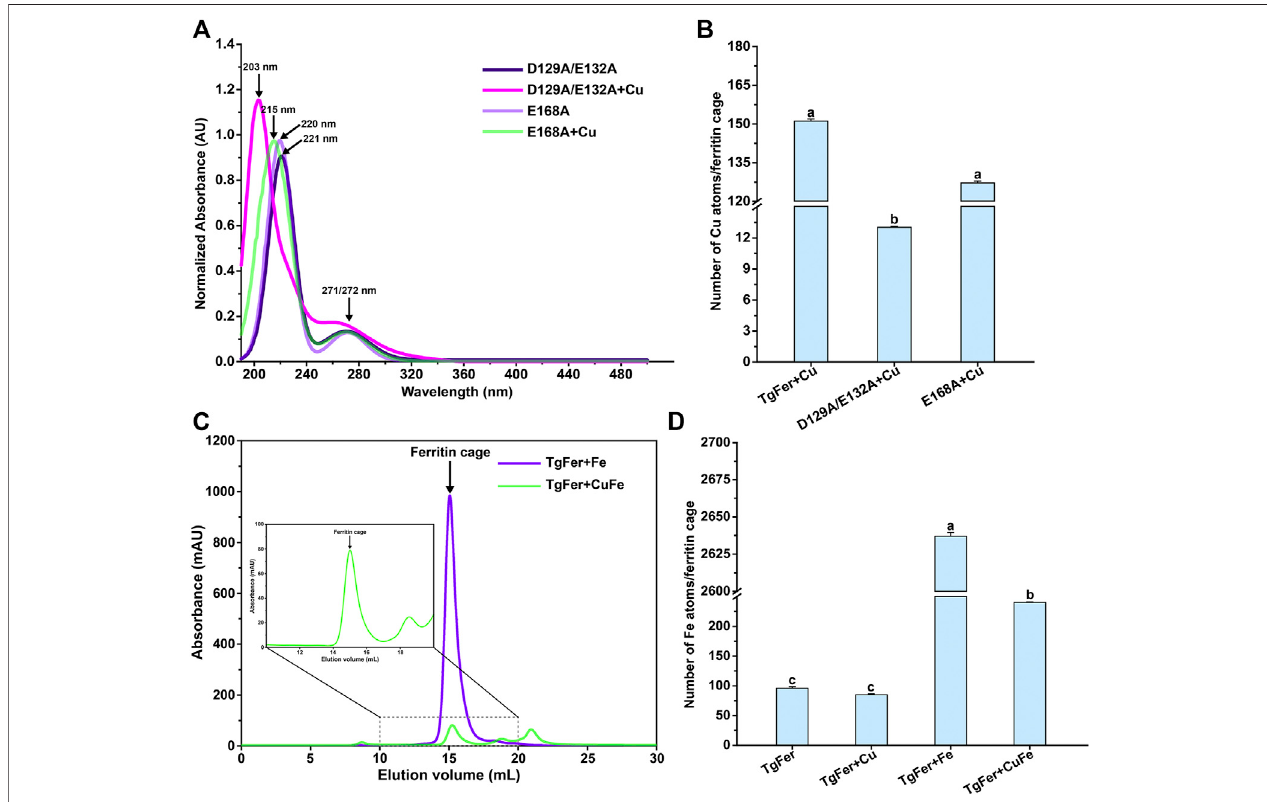
FIGURE 7 | (A) UV – vis absorbance spectrum for E168A and D129A/E132A and those proteins of treated with Cu 2+ ions. (B) The determination of copper atom contentsindifferentvariantferritintreatmentgroupsbyICP-MS. (C) Gel- fi ltrationchromatographypro fi leforTgFer+FeandTgFer+CuFe.Thepeakofthetargetprotein is marked with a black arrow. (D) The determination of iron atom contents in different ferritin treatment groups by ICP-MS. The values are indicated as the mean ± SEM ( n = 3).